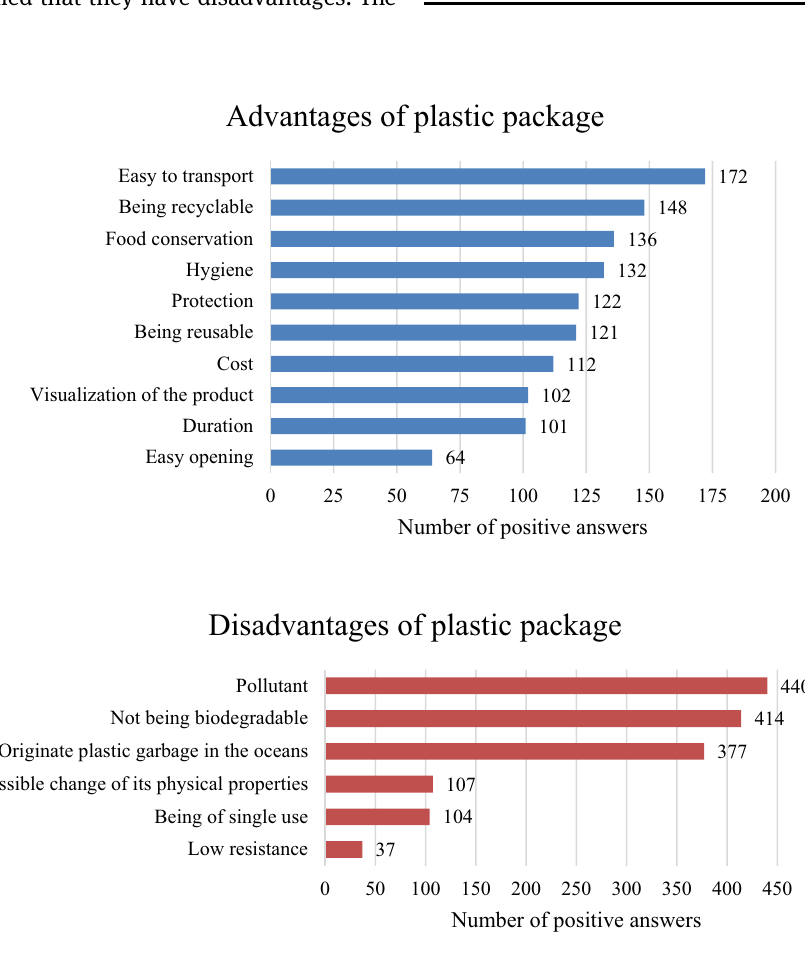
Figure 4: Advantages and disadvantages of plastic food packaging perceived by